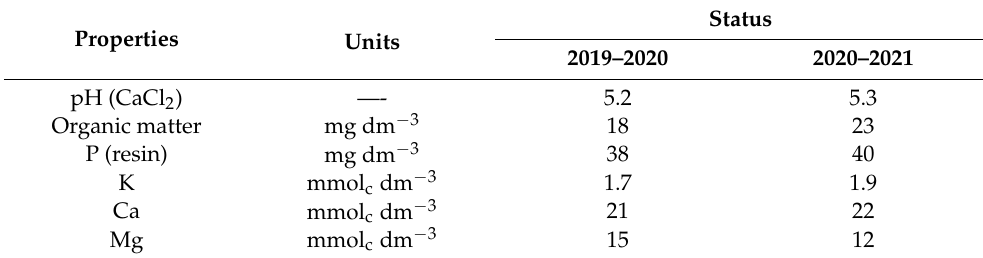
Table 5. Pre-maize experiments soil analysis of composite sample in a soil layer (0–0.20 m)